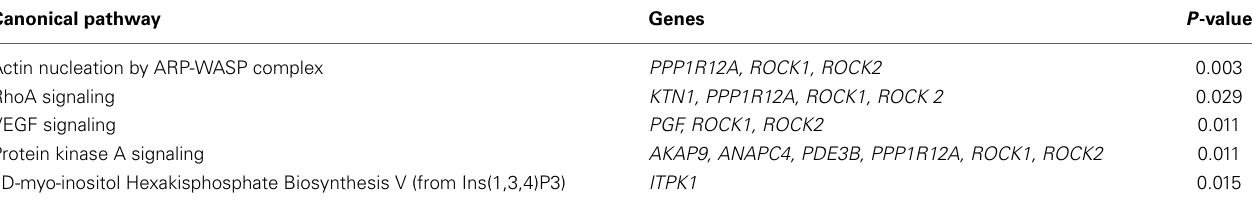
Table 6 | Canonical pathway analysis of the depressed